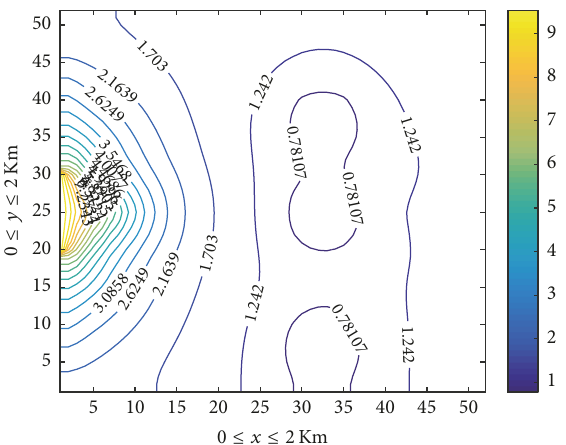
Figure 13: The approximated pollutant concentrations over 5 mon- itoring nodes, when the eastern exit gate is opened on 0–100 min, 33–100min, and 66–100 min.